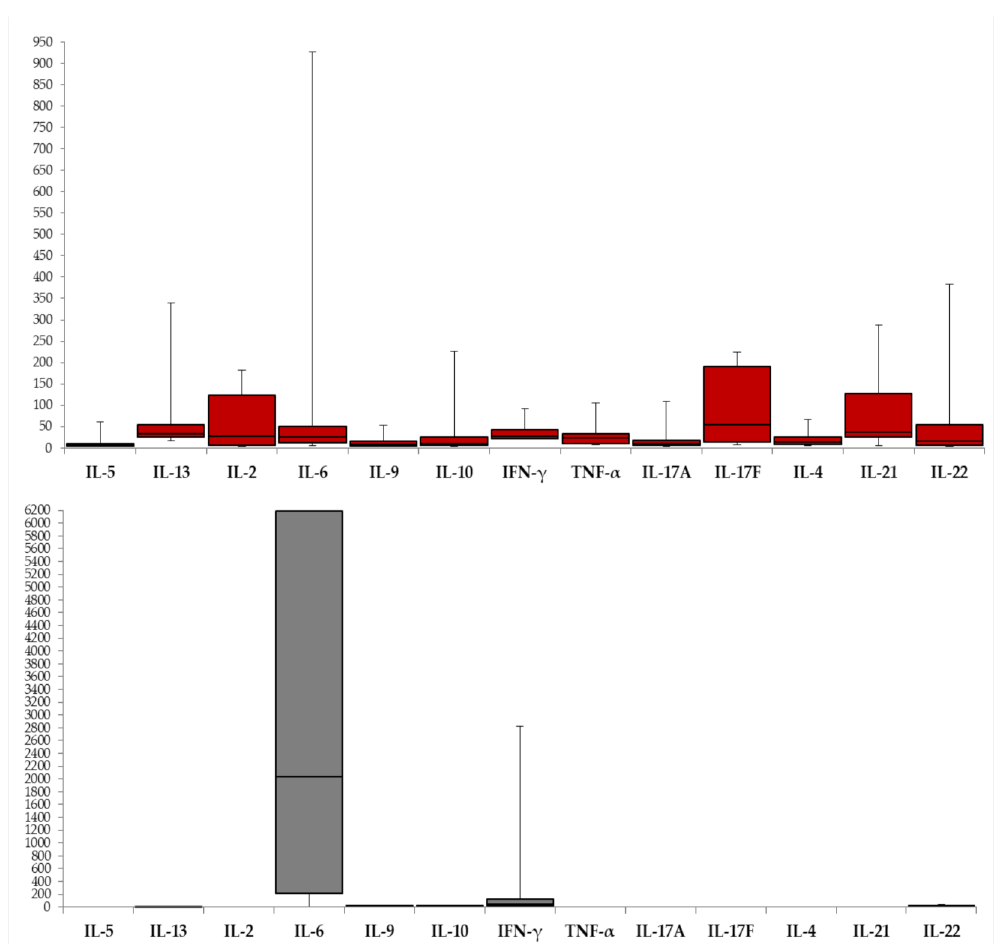
Figure 1. Cytokine expression pattern (pg/mL) in serum (red box plots) and CSF (grey box plots) in patients with WNV infection. Boxes represent median and interquartile range. Error bars indicate the minimum and maximum values. Table 5. Comparison of serum and CSF cytokine levels and patient’s age, sampling time and clinical diagnosis.